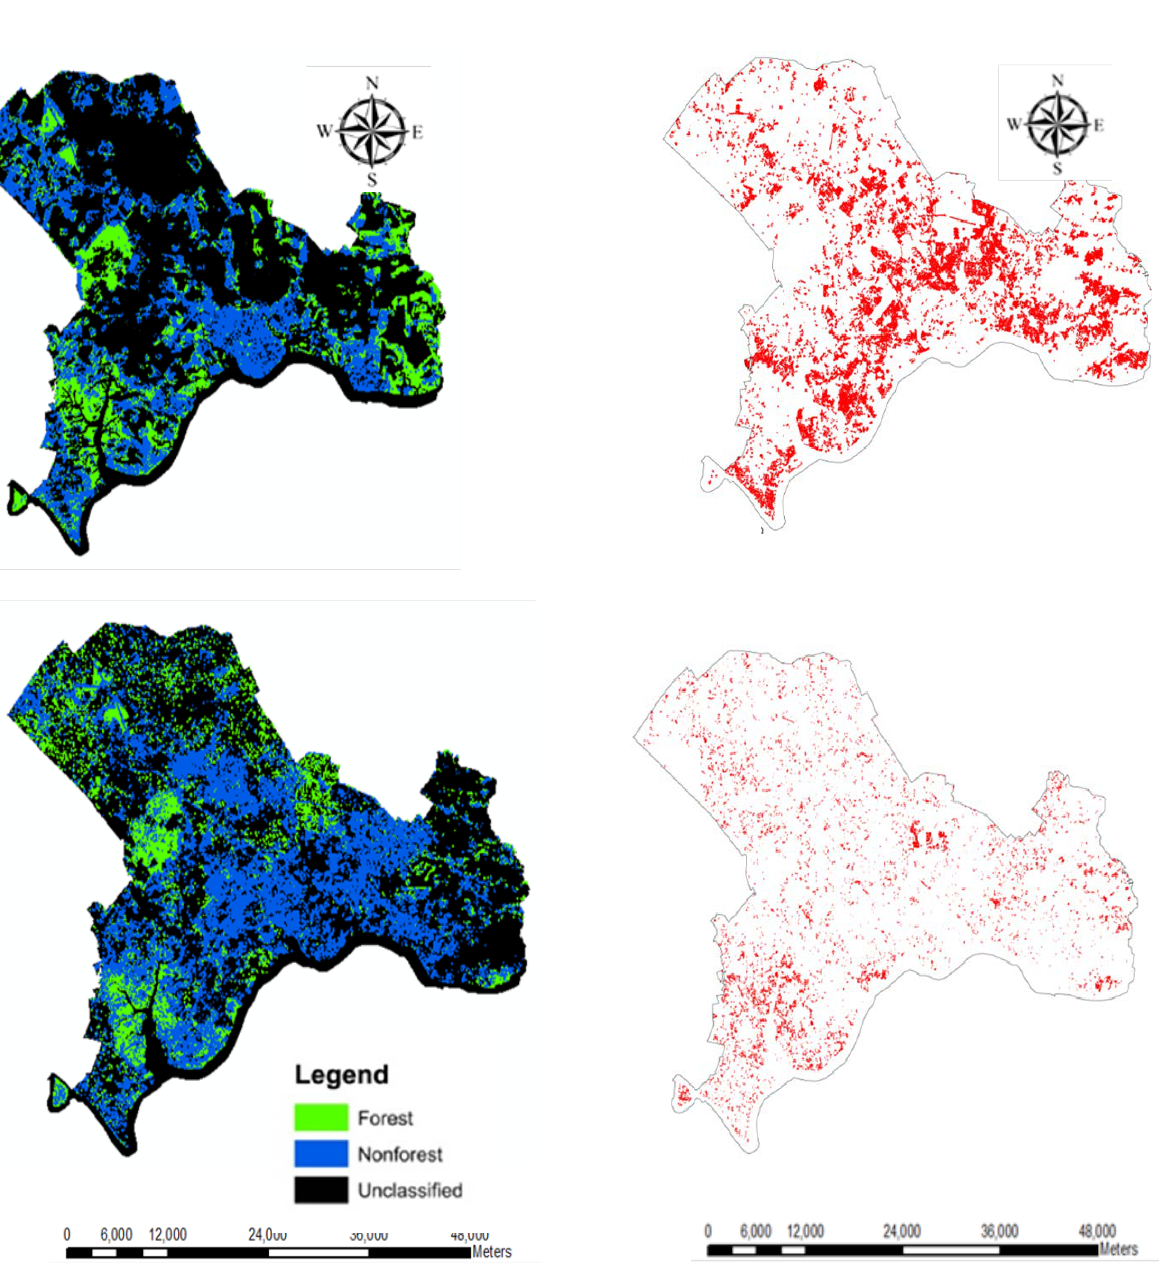
Figure 4. Deforestation (top panel) and disturbance (bottom panel) between 1990 and 2010 in Iskandar